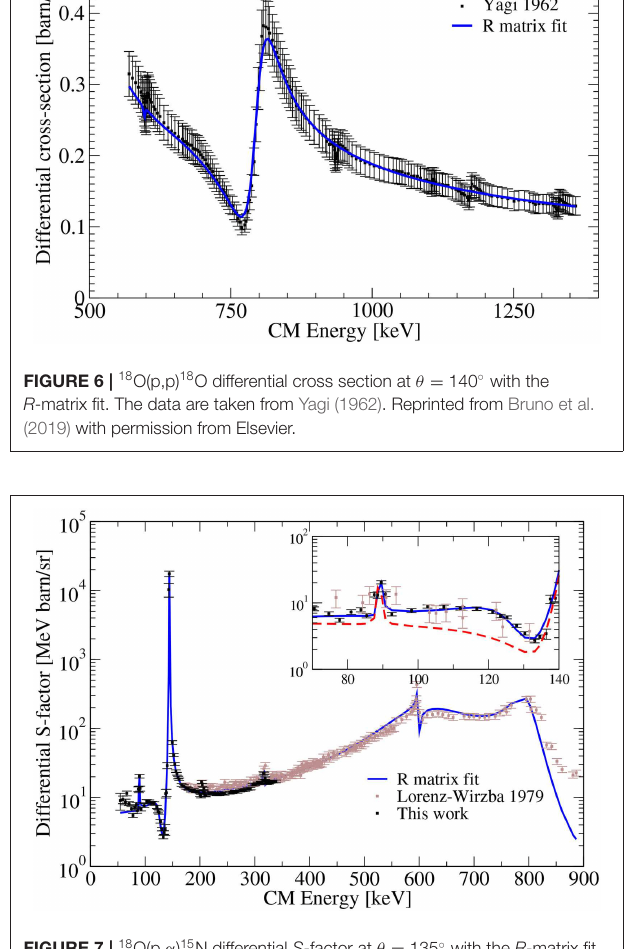
FIGURE 7 | 18 O(p, α ) 15 N differential S -factor at θ = 135 ◦ with the R -matrix fit. The red dashed lined in the inset shows the effect of removing the new state at E = 106 keV. Reprinted from Bruno et al. (2019) with permission from